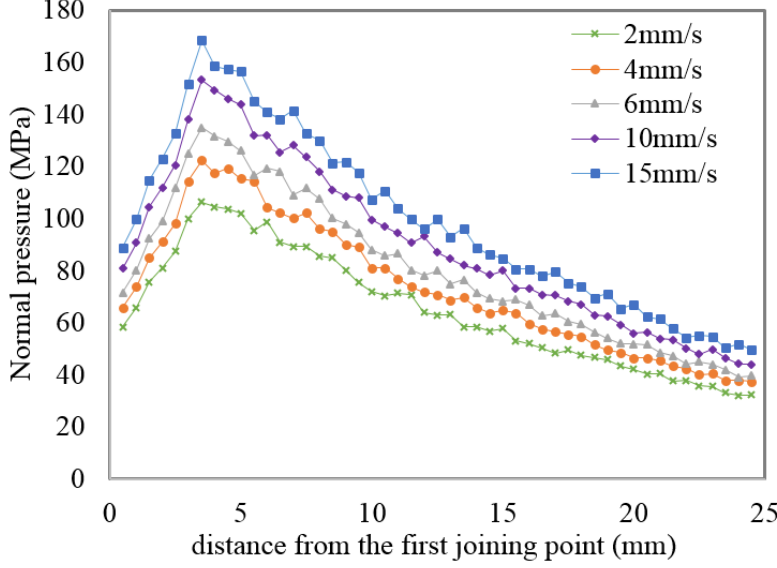
Figure 5. Normal pressure within the welding chamber at different ram speeds and at a billet temperature of 470